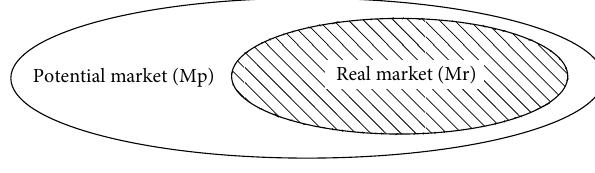
Fig. 2. Potential and real